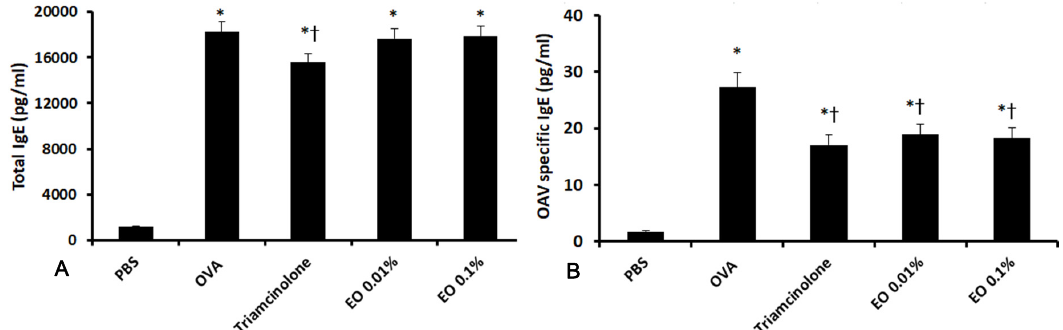
Figure 2. Effects of essential oil from Chamaecyparis obtusa (EOCO) on total serum IgE ( A ) and ovalbumin (OVA)-specific IgE ( B ) level (n = 8 mice per group). Triamcinolone suppressed both total serum IgE and OVA-specific IgE levels, whereas EOCO only suppressed OVA-specific IgE level. PBS, phosphate-buffered saline; OVA, ovalbumin; * ( p < 0.05) versus the PBS group; † ( p < 0.05) versus the OVA group.